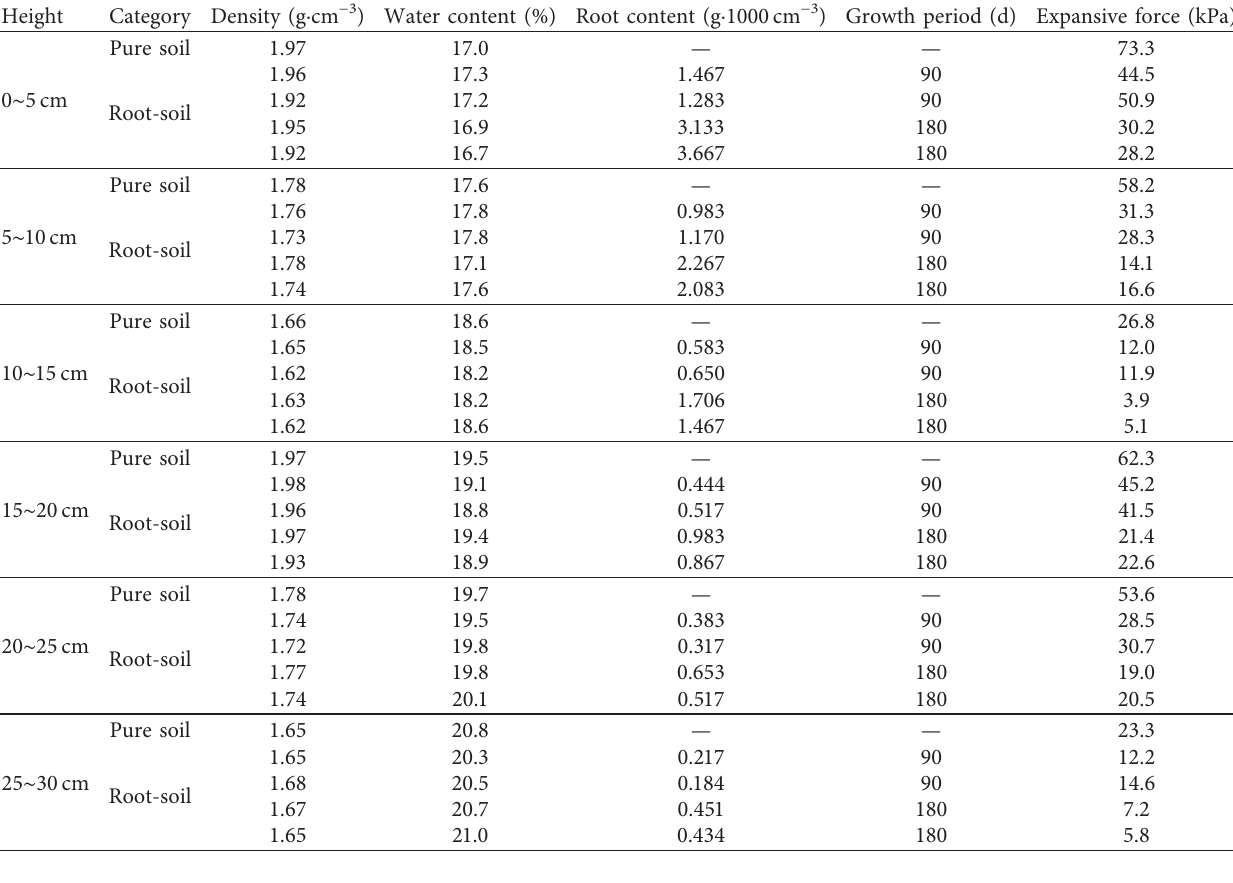
Table 2: Expansive force test results.